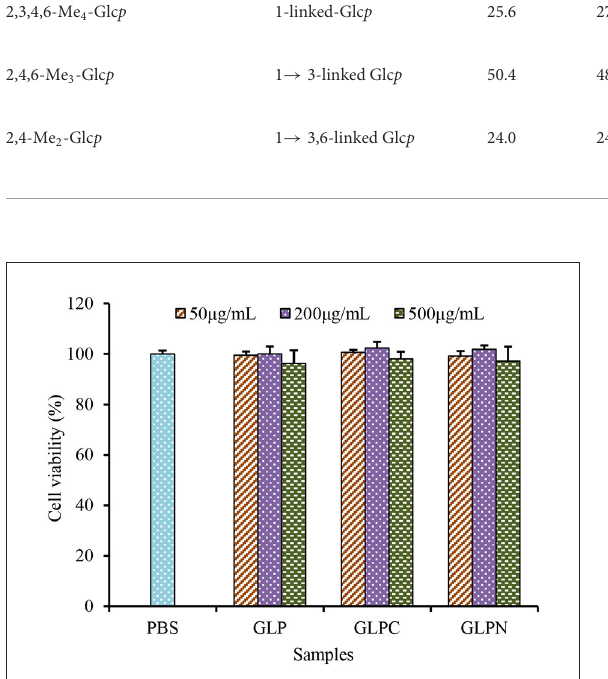
FIGURE4 Effects of GLP and the degraded fractions (GLPC and GLPN) on cell viability of Caco-2